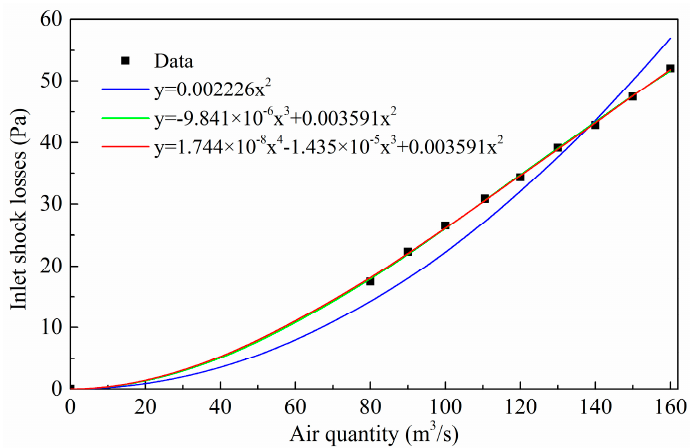
Figure 7. Airflow streamlines in the intake airway.